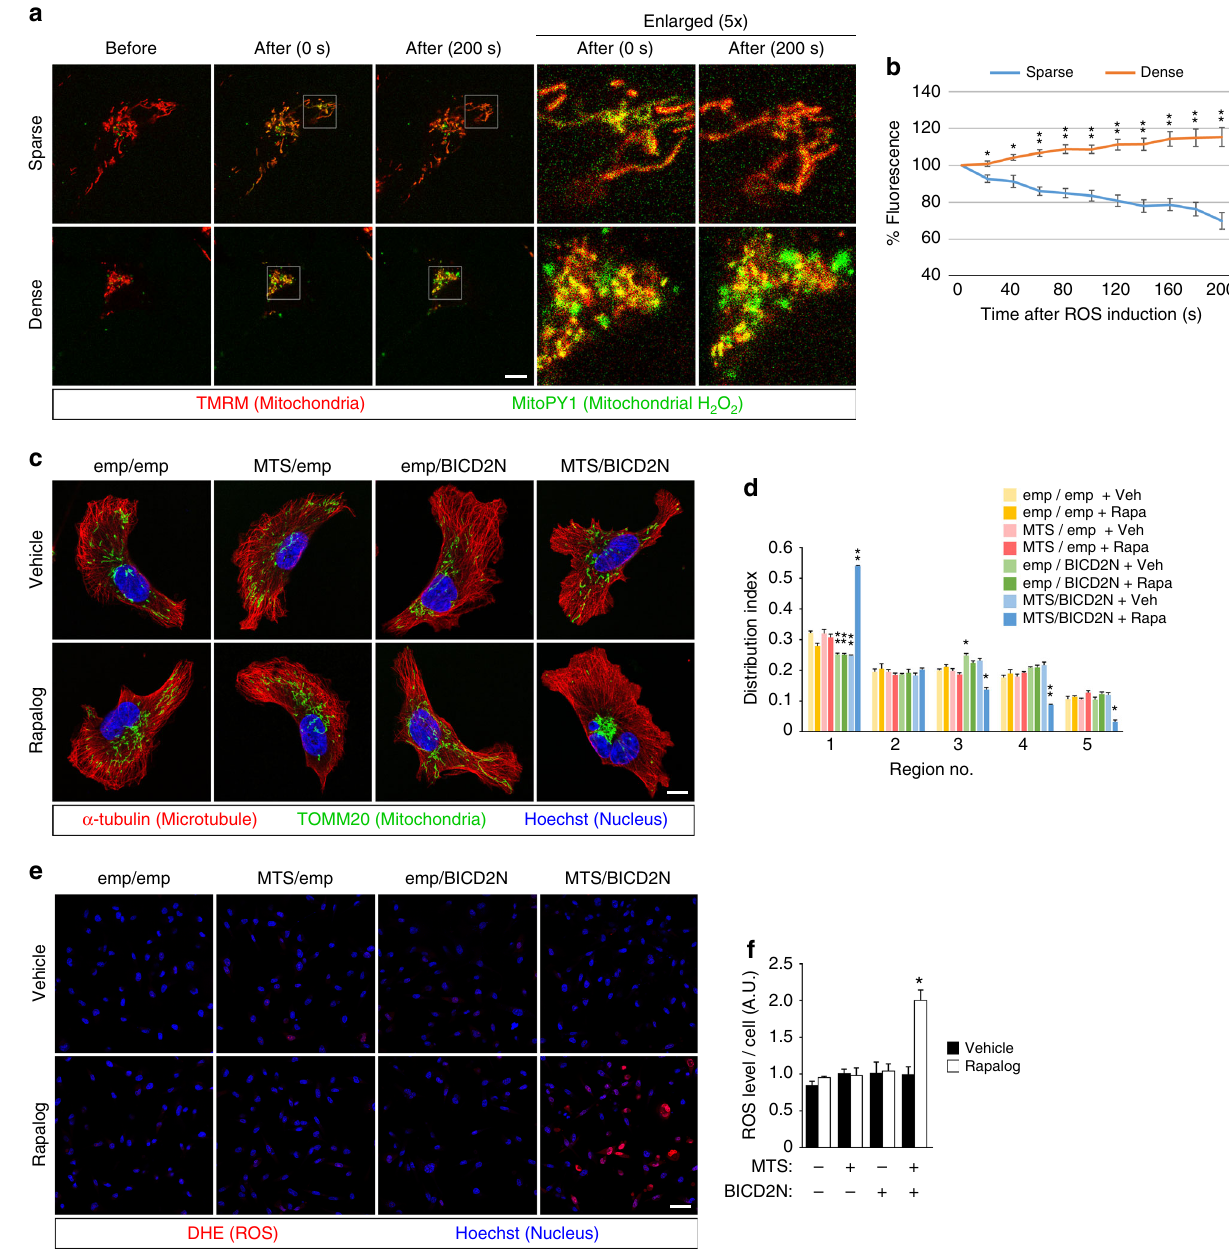
Fig. 2 ROS Ampli fi cation by dense mitochondria within a single breast cancer cell. a Visualization of mitochondrial H 2 O 2 in MDA-MB-231 cells. Mitochondria were labeled with TMRM (red), and H 2 O 2 was visualized using MitoPY1 (green). Time-lapse images of the cells with sparse or dense mitochondria, before and after ROS induction by photoexcitation of TMRM, are shown. The white squares indicate the enlarged areas shown on the right. To avoid fl uorescence saturation, the laser power for the excitation of TMRM (to visualize mitochondria) was reduced by several fold in dense condition. Bar, 10 μ m. b Quanti fi cation of the time-dependent changes of MitoPY1 fl uorescence in cells with dense or sparse mitochondrial networks. c – f MDA-MB- 231 cells were stably transfected with FKBP-MTS (MTS) and/or BICD2N-FRB* (BICD2N), and treated with either vehicle or AP21967 (Rapalog). The empty vector (emp) was also used as a control. c , d Mitochondrial distribution was visualized by immunostaining ( c ), and quanti fi ed ( d ) as above. Bar, 10 μ m. e , f ROS production was visualized by DHE ( e ), and quanti fi ed ( f ) as above. Bar, 50 μ m. All graphs indicate the mean ± SEM for 10 ( b ) or three ( d , f ) independent experiments. * and ** indicate P < 0.05 and P < 0.005 (two-tailed t -test, adjusted by the Holm – Sidak method), compared to the corresponding samples (sparse vs. dense in b , emp/emp vs. others in d and f ),